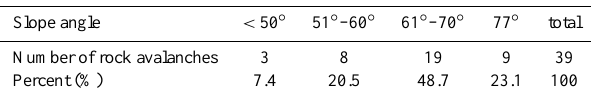
Table 5. Distribution of rock avalanches by slope angle(from Insti- tute of Geography of Sichuan